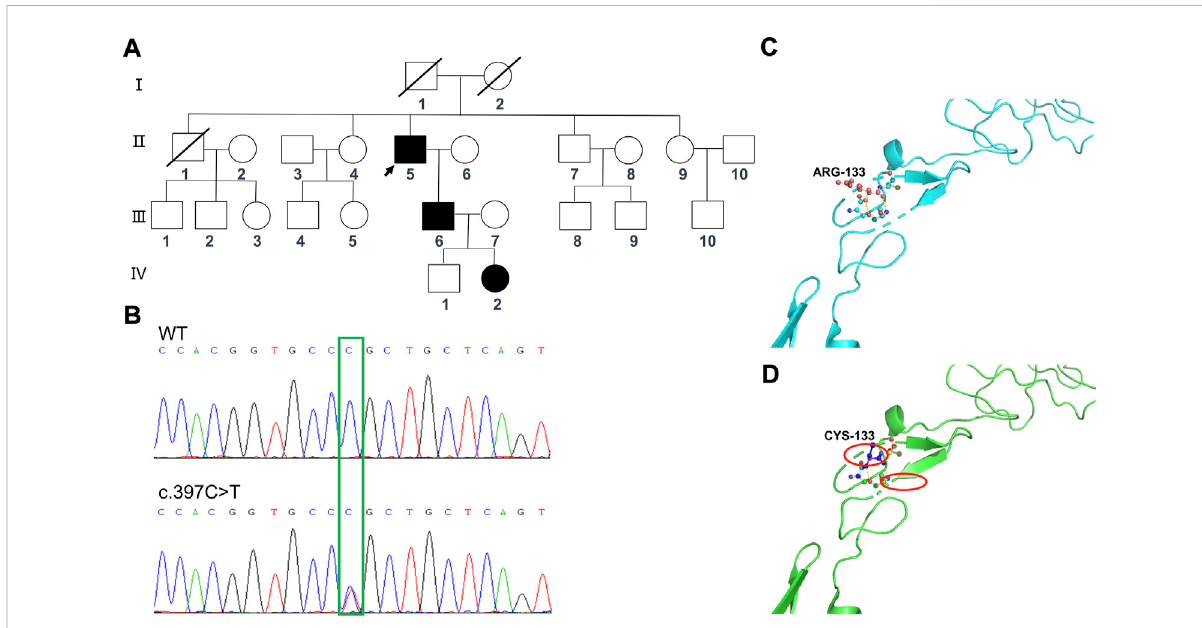
FIGURE 4 Sequencing analysis of the NOTCH3 (c.397C > T) mutations in the family members, and predicted computational tertiary structure of the NOTCH3 protein. (A) Squares denote male family members; circles denote female family members; slashed symbols represent deceased family members; fully shaded symbols represent symptomatic family members; and arrows indicate the proband. (B) The affected nucleotide is indicated with an arrowhead. The family members Ⅱ :6, Ⅱ :7, Ⅱ :9, Ⅲ :8, Ⅲ :9, Ⅲ :10, and Ⅳ :1 are wildtypes, while the family members Ⅱ :5, Ⅲ :6, and Ⅳ :2 have the c.397C > T mutation. The predicted computational tertiary structure of the wild genotype NOTCH protein (C) and the mutant genotype (D) . An amino acid change resulting from a non-synonymous substitution, with arginine replacing